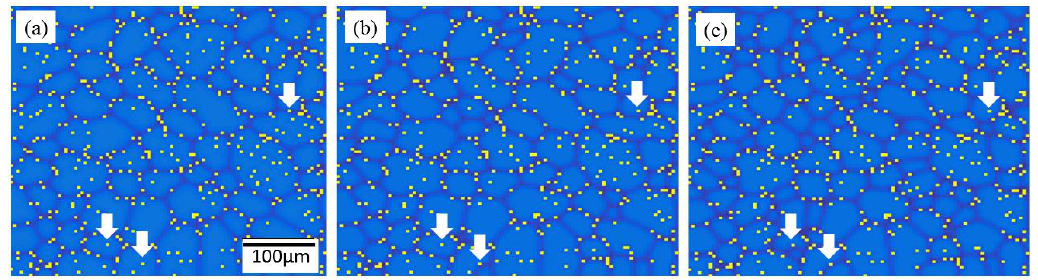
Figure 8. Grain morphology for 600 s austenitization at temperatures of ( a ) 1300 °C, ( b ) 1250 °C, and ( c ) 1100 °C.